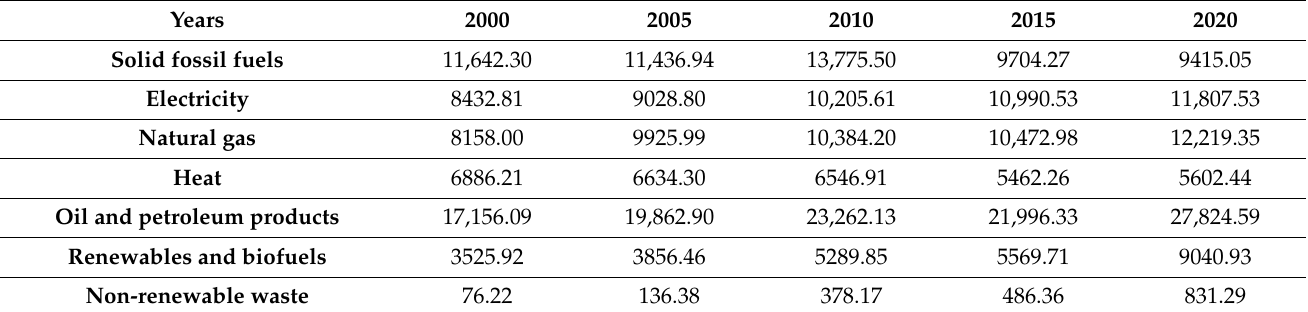
Table 1. Final energy demand structure in Poland over the period 2000–2020 (thousand tonnes of oil equivalent). Source: Own elaboration based on Eurostat data [19].